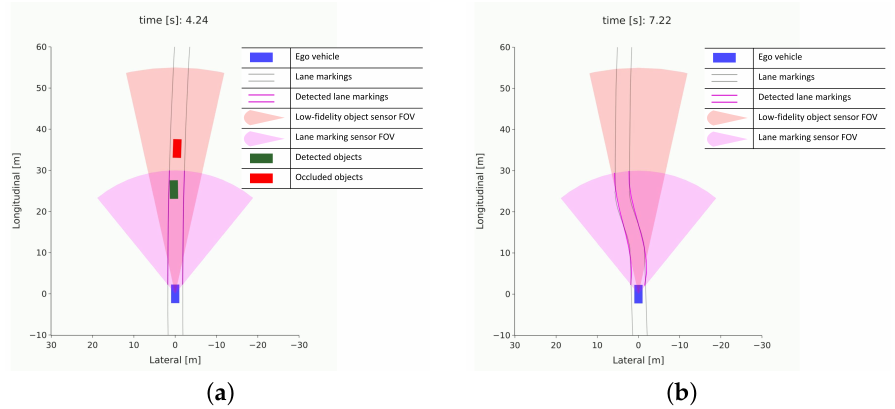
Figure 16. Visualisation of both ALKS simulation setups from the sensor model point of view. ( a ) Cut-out scenario (ALKS with standard ODD). ( b ) Construction scenario (ALKS with extended